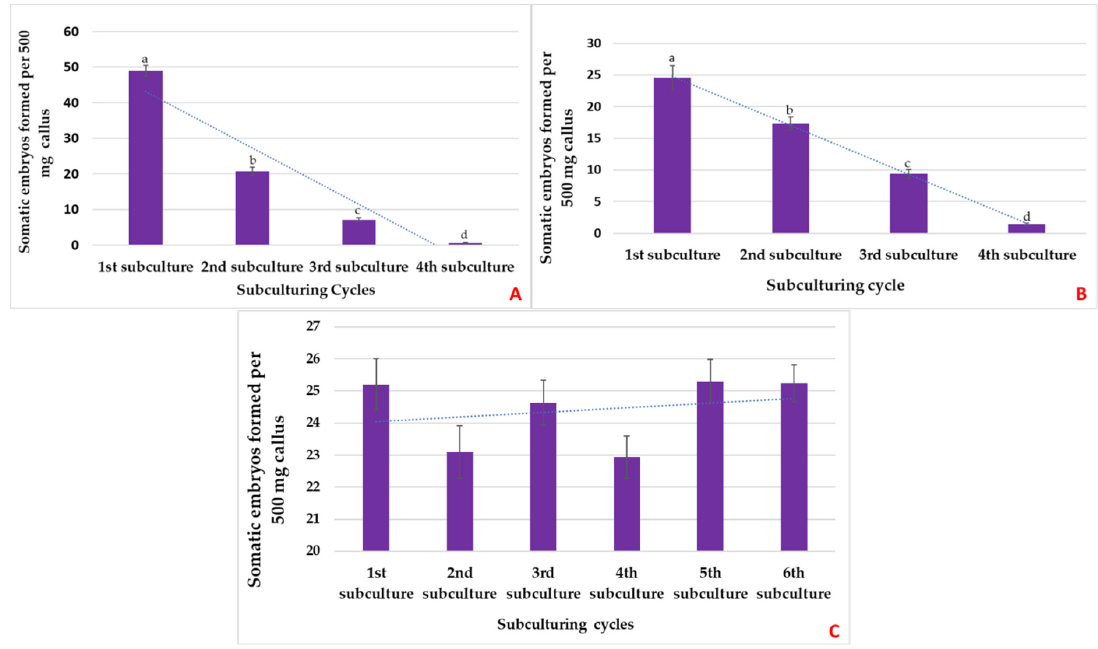
Figure 8. Embryogenic sustainability through subculturing cycles. ( A ) The B5h callus, ( B ) MS2D callus and ( C ) SH4K callus. The B5h callus and MS2D callus both gradually lost embryogenic potential through the subculturing cycles where the SH4K callus retained its embryogenic potential even after six subcultures without showing any significant loss in the embryo yield. Values represent means ± SDs ( n = 30) and different letters indicate significant differences according to the Tukey Kramer HSD test at p ≤ 0.05.